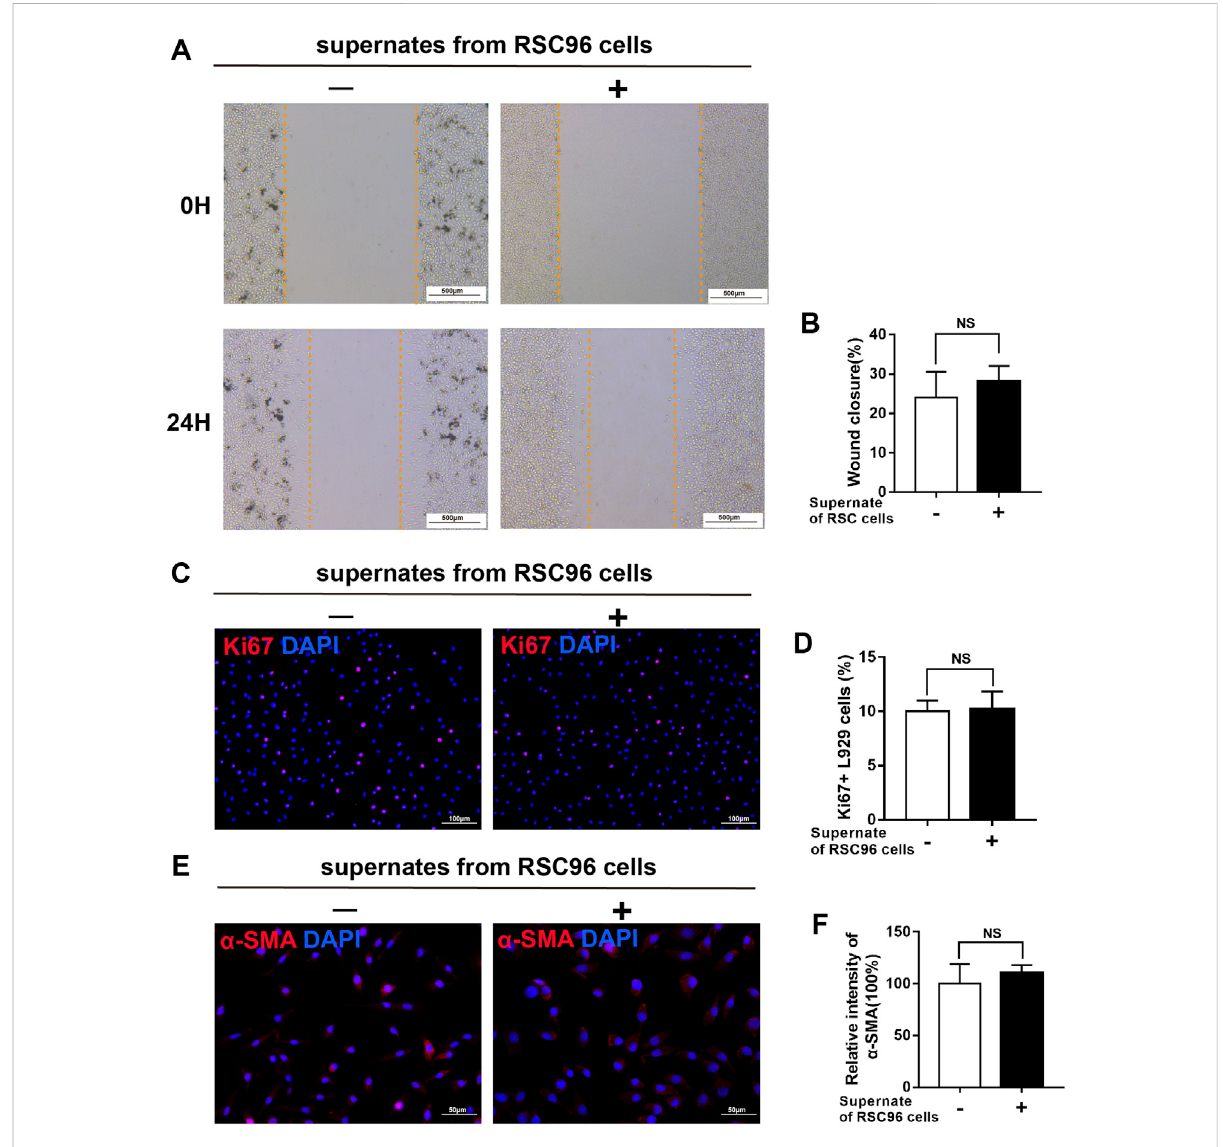
FIGURE 9 High glucose attenuates the paracrine effect of SCs on fi broblasts. (A,B) A scratch assay of L929 fi broblasts cultured in 50 mM glucose and treated for 0 or 24 h with (+) or without ( − ) supernates from RSC96 cells cultured under the same glucose conditions. Representative immuno fl uorescence analyses of Ki67 (C) and α -SMA (E) , and the numbers of Ki67 + cells (D) and intensity of α -SMA immunoreactivity (F) , in L929 fi broblasts cultured and treated as described for (A,B) . Data are presented as mean ± SD of three independent experiments, Student ’ s t